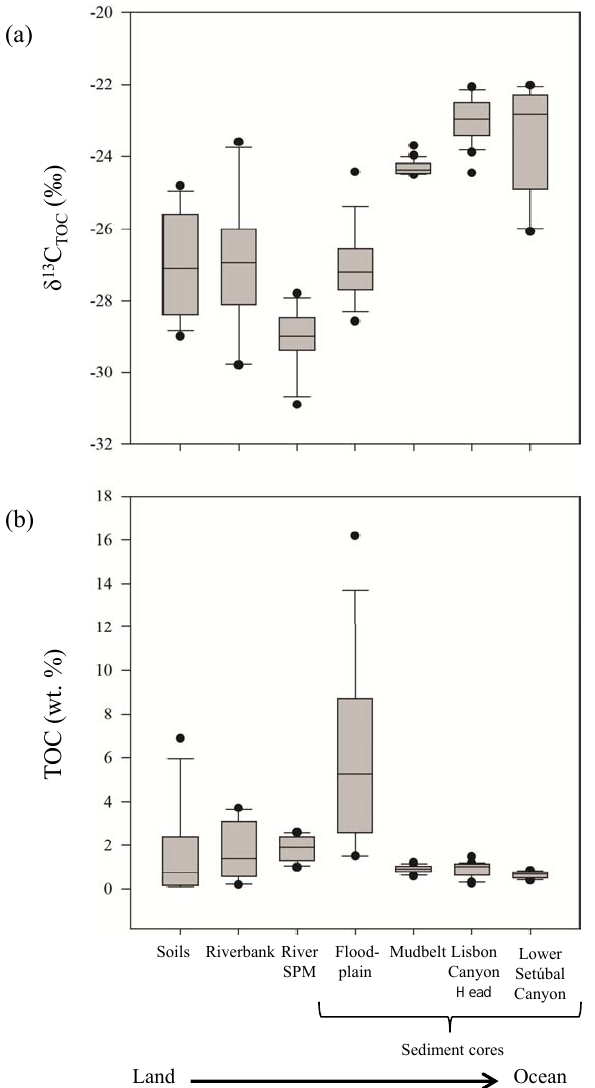
Figure 2. Box plots of (a) δ 13 C TOC (‰) of the organic carbon and (b) TOC (wt%) for each sample set along the Tagus River source to sink transect. The increasing δ 13 C TOC values in the sediment core locations with increasing distance from the coast indicate that more of the organic carbon in these sediments is